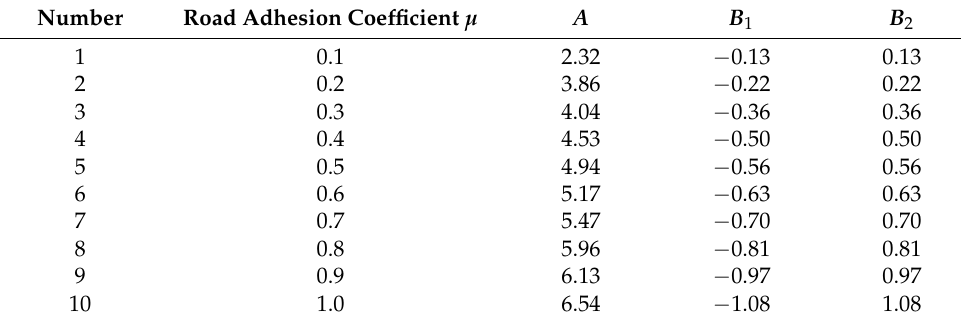
Table 3. Boundary parameters under different road adhesion coefficients.